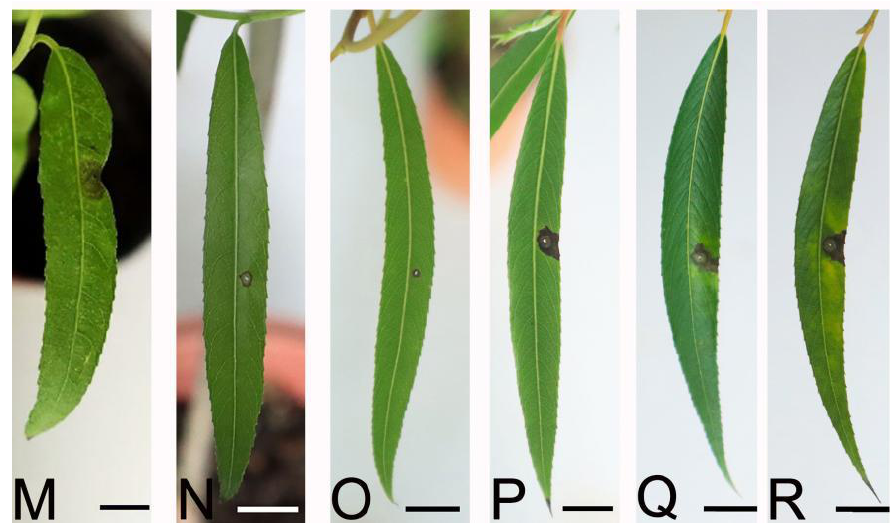
Figure 7. Symptoms on the leaves of Salix babylonica seedlings on day 7 after inoculation with conidial suspensions. ( A ) Control. ( B – D ) isolates HQ2-1, HQ2-6, and WH2-9 ( Colletotrichum aenigma ). ( E , F ) isolates SD1-6 and SD1-9 ( C. fructicola ). ( G – I ) isolates WH2-4, NL1-7, and MXL1-7 ( C. gloeosporioides ). ( J – R ) isolates YH2-2, YH2-3, YH2-5, YH2-6, WH2-7, NL1-10, NL1-13, MXL1-1, and MXL1-10 ( C. siamense ). Scale bars = 1 cm. Table 2. The infection severity of representative Colletotrichum isolates on leaves of Salix babylonica . No. Species